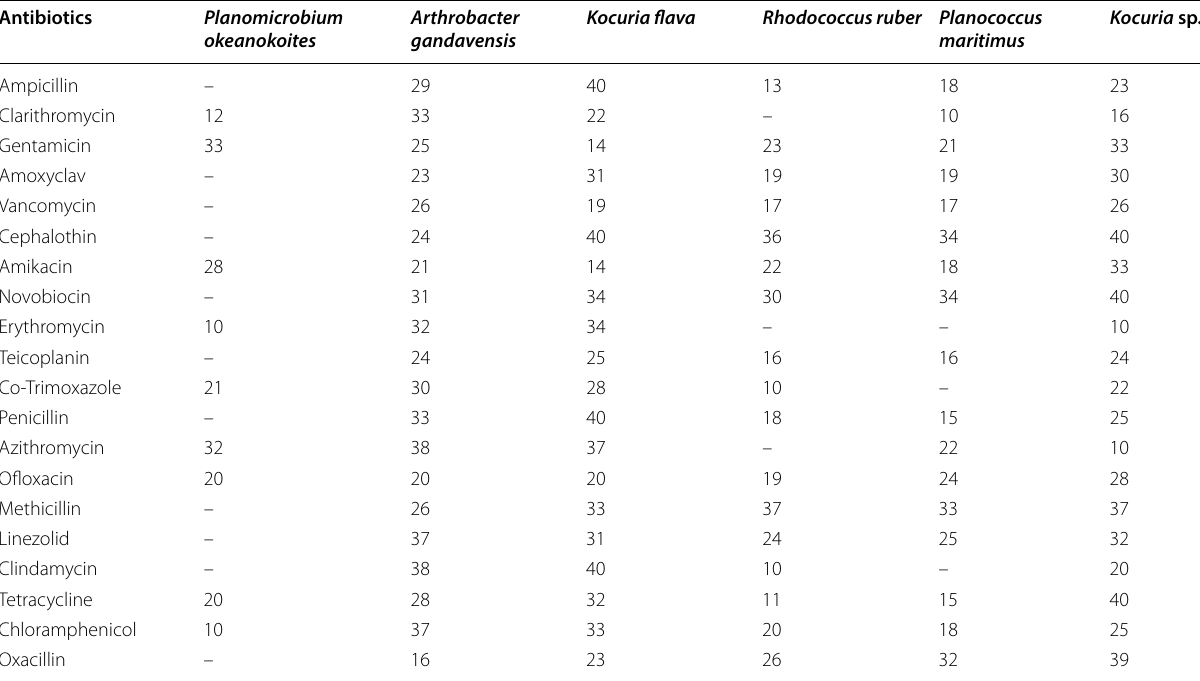
‘–’ indicates resistant